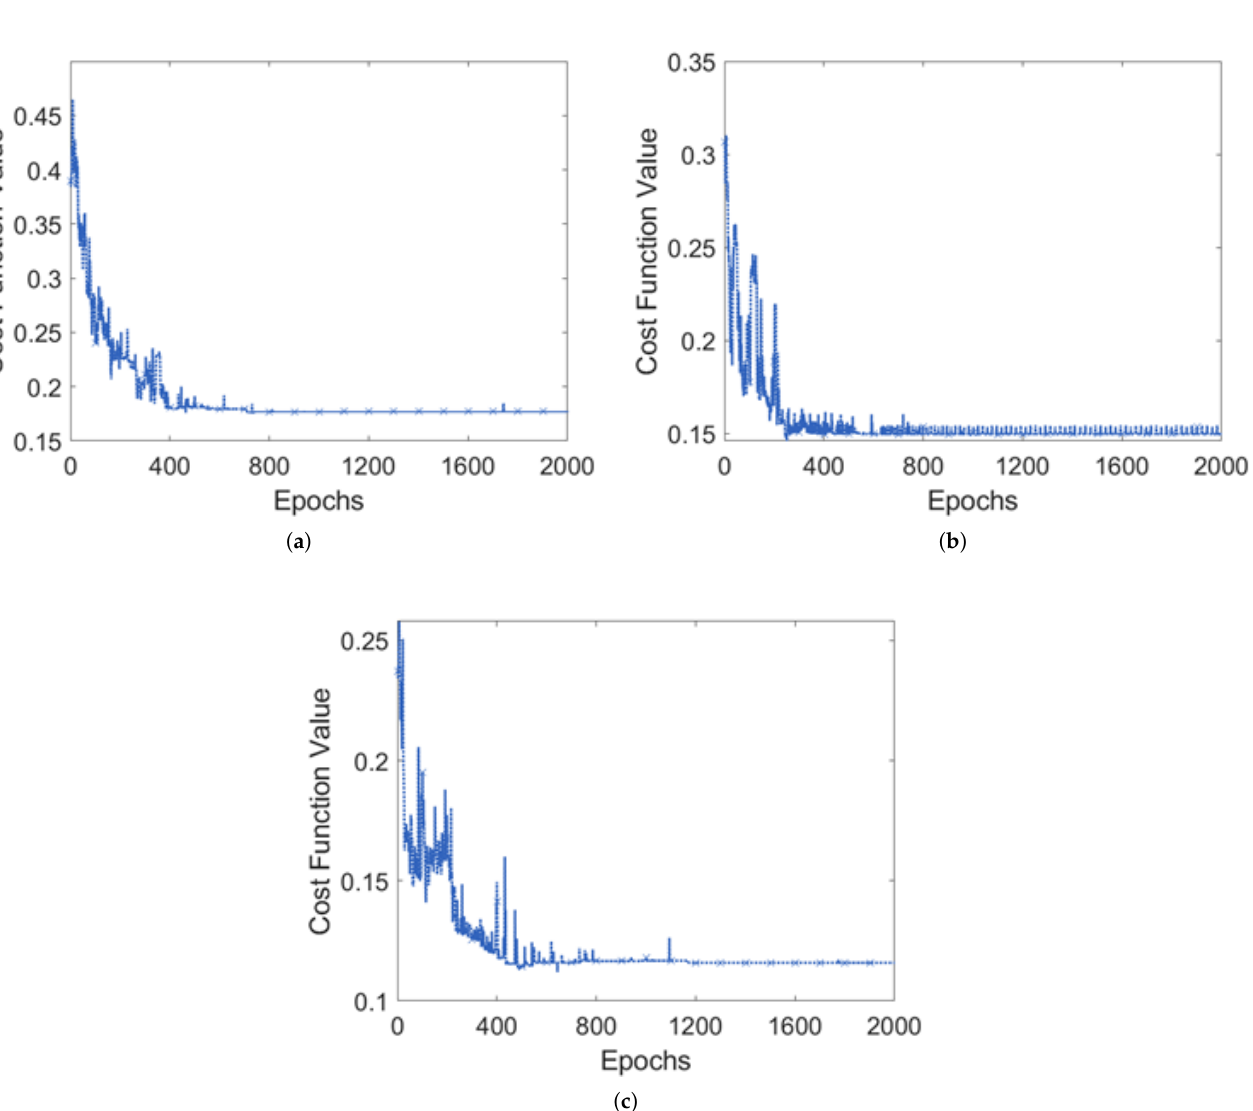
Figure 5. Number of BS = 120 and Number of ES = 20. ( a ) Random Seed = 5. ( b ) Random Seed = 8. ( c ) Random Seed =